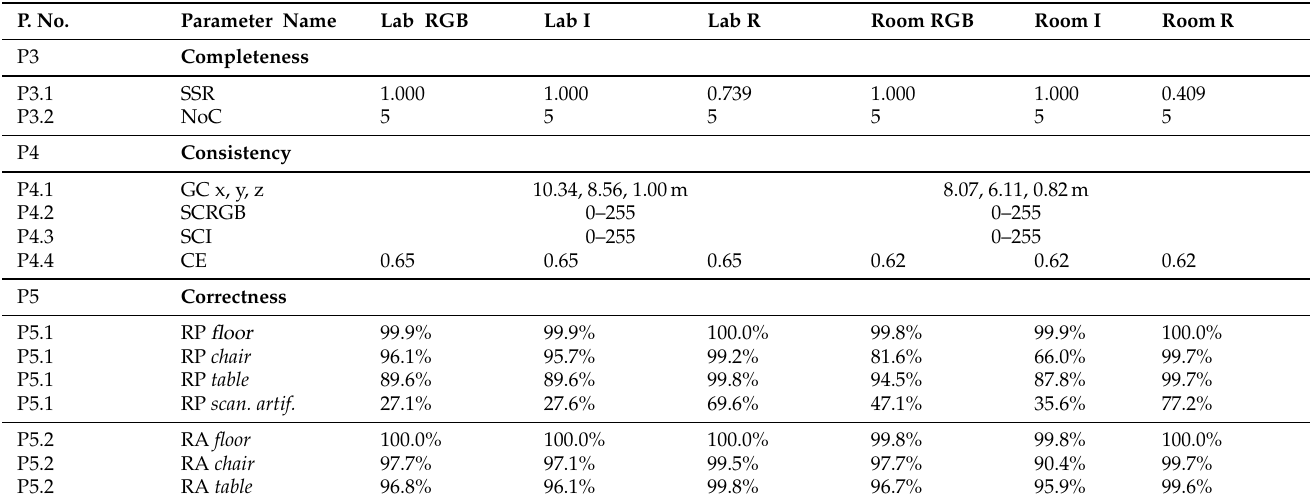
Table 13. Calculated and determined values for the quality parameter of